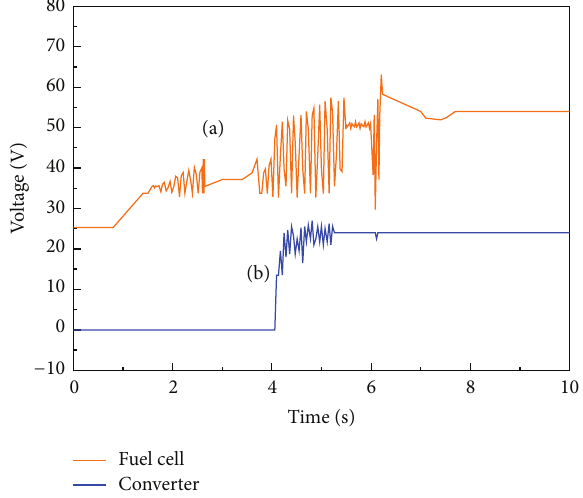
Figure 10: Variation of fuel cell stack voltage and DC-DC converter voltage in absence of external load.